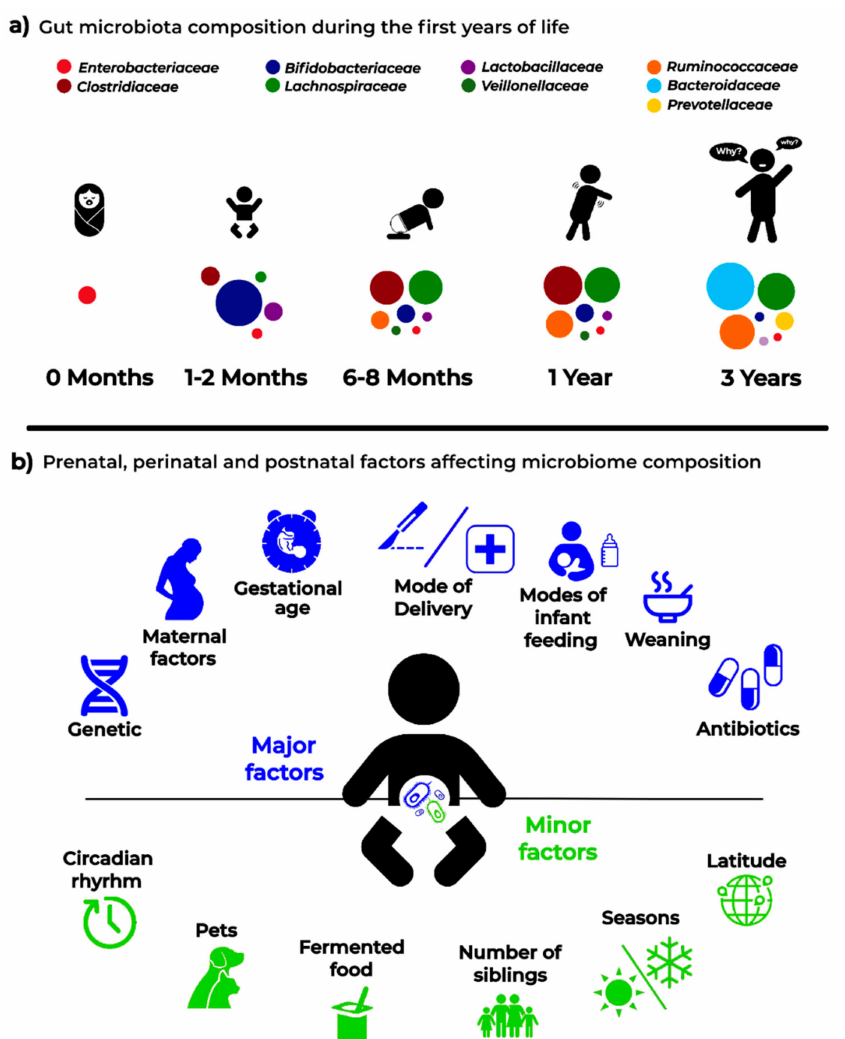
Figure 2. Infant microbiota composition ( a ) and the main “major” and “minor” factors a ff ecting analysis and results in microbiota studies ( b